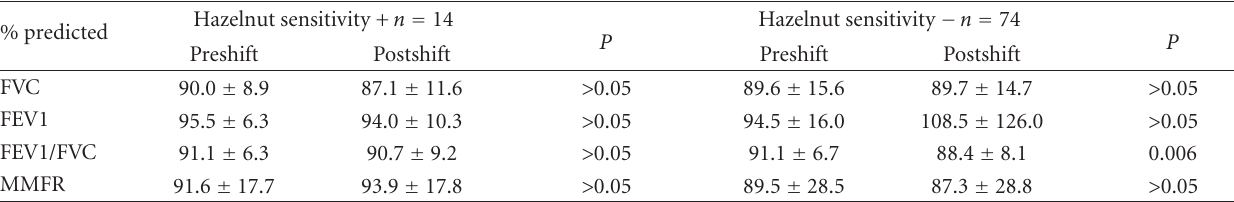
Table 5: Pre- and postshift spirometric values of hazelnut workers.